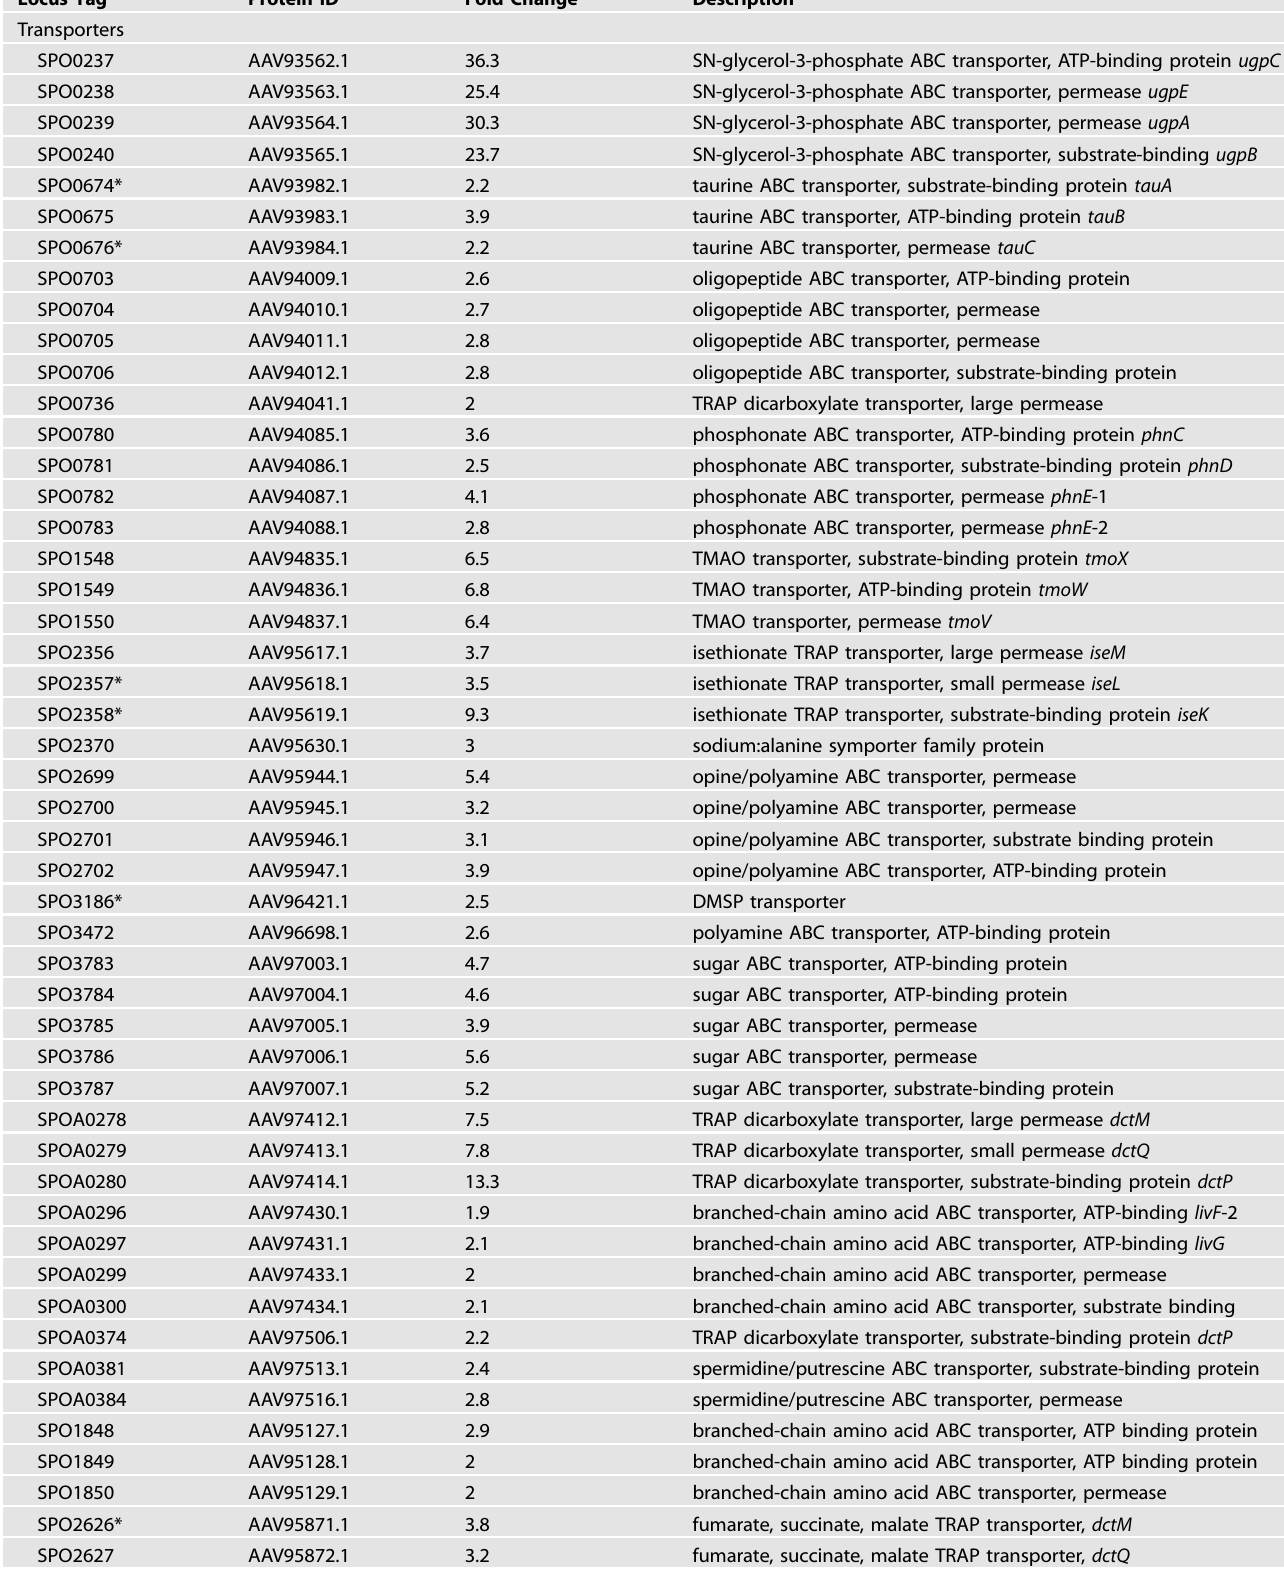
Table 1. Signi fi cantly enriched genes for transporter systems, catabolic enzymes, and carbohydrate-active enzymes in the transcriptome of R. pomeroyi DSS-3 in co-culture with M. commoda . Locus